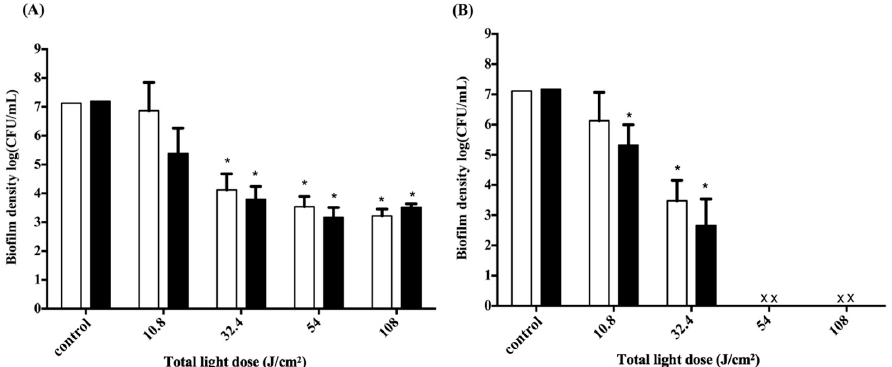
Figure 3. Cell survival fraction of S. aureus biofilm in 3D gingival model after incubation with F-2 for 0.5 h, and subjected to various doses of light illumination from two sides. After PDI, S. aureus biofilm was maintained in contact with F-2 for 0.5 h ( ☐ ) and 2 h ( ) prior to plate count. ( A ) Non-illumination side; ( B ) illumination side. The locations of ( A ) and ( B ) are shown in Figure 1B. Each value is the mean of three independent experiments ± standard deviation. * p < 0.05.